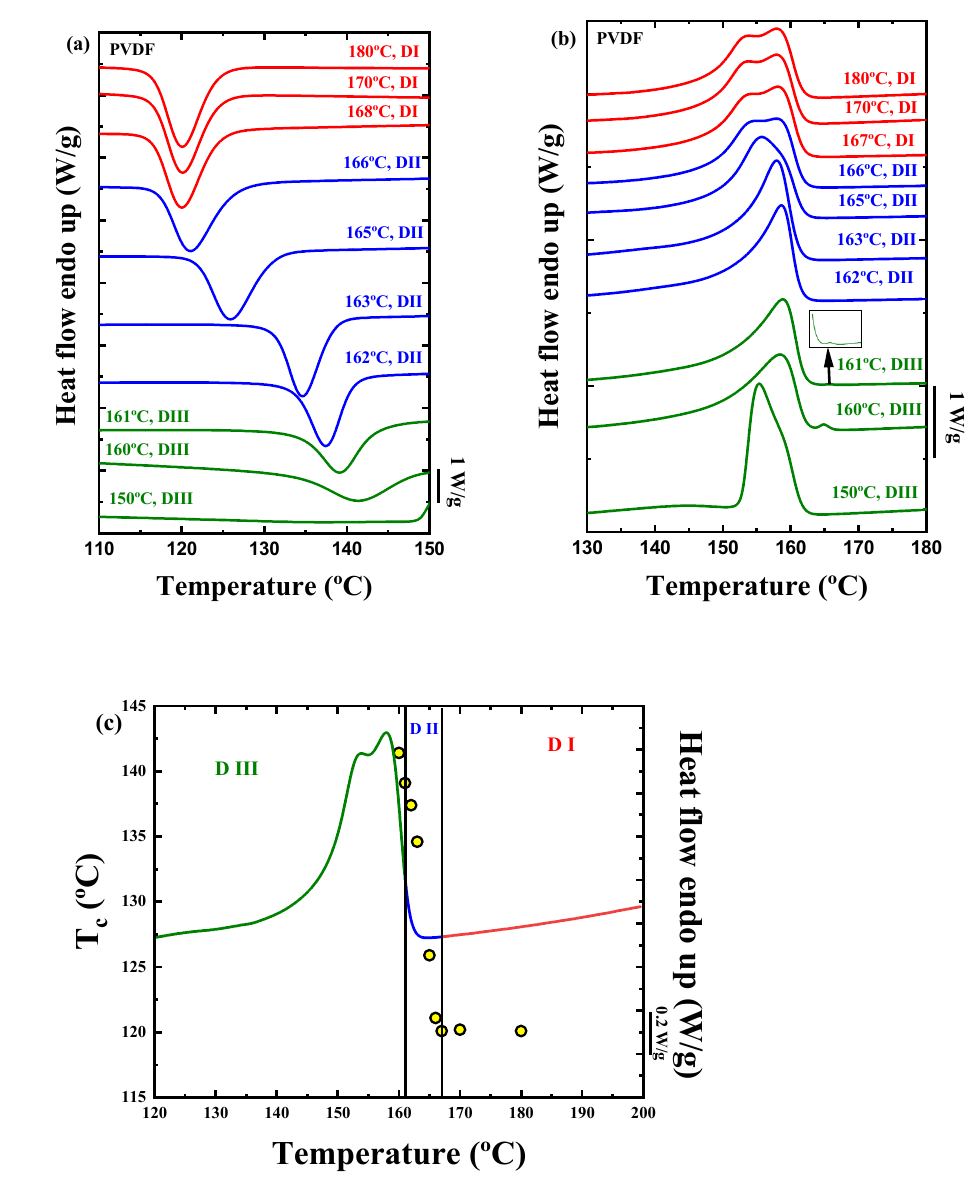
Figure 9. ( a ) DSC cooling scans after 5 min at the indicated T s values, ( b ) subsequent DSC heating scans for the PVDF homopolymer, and ( c ) representation of each Domain in the self-nucleation process superimposed on a standard melting curve of the PVDF homopolymer sample. The circles represent the crystallization temperatures (left Y -axis) at the corresponding T s values ( X -axis).